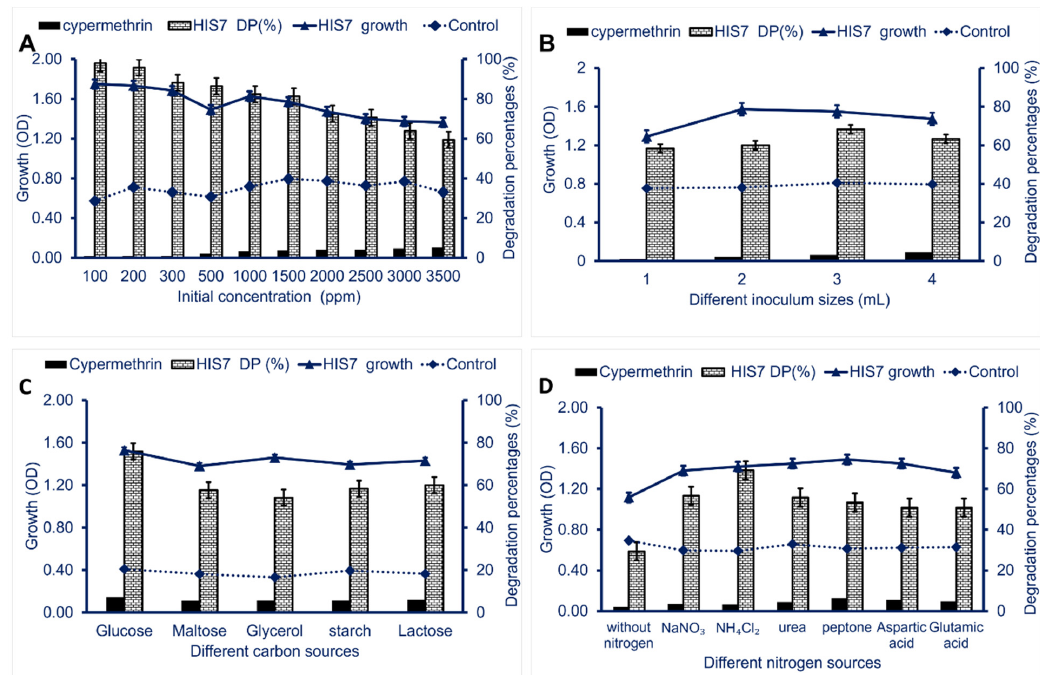
Figure 4. The optimization process of cypermethrin bacterial degradation. Panel ( A ) denotes different cypermethrin concentrations; panel ( B ) denotes the bacterial inoculum size; panel ( C ) denotes different carbon sources, and panel ( D ) denotes different nitrogen sources. Cypermethrin meaning the abiotic degradation percentages of insecticide in MS liquid media in absence of bacterial inoculation; HIS7 DP (%) denotes the degradation percentages of cypermethrin in MS liquid media in presence of Lysinibacillus cresolivuorans strain HIS7; HIS7 growth denotes the bacteria growth (O.D.) in MS liquid media containing cypermethrin; Control denotes the bacterial growth (O.D.) in MS liquid media in absence of cypermethrin. Data represented by Mean ± SE (n = 3). The standard deviation is less than the size of symbols if no error bars are seen.